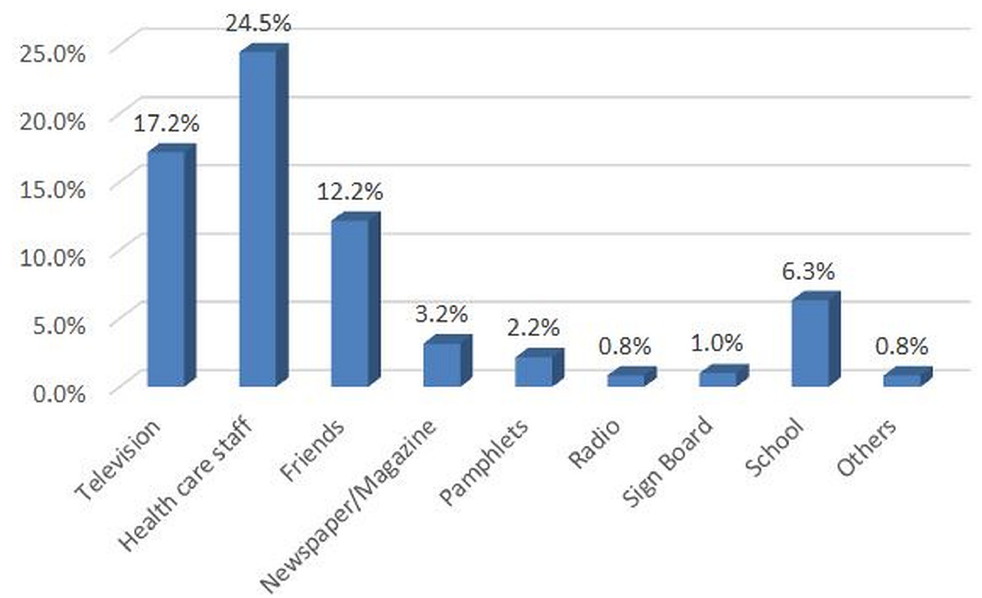
Figure 4. Source of information of participants* about Japanese encephalitis in the Japanese encephalitis survey, Yangon region, Myanmar (2019) **. Y axis as percentage (responded ‘yes’). *Parent or guardian of the 1–15 year-old children available at time of survey, preferably mother. **Weighted estimates given taking into account the sampling design.